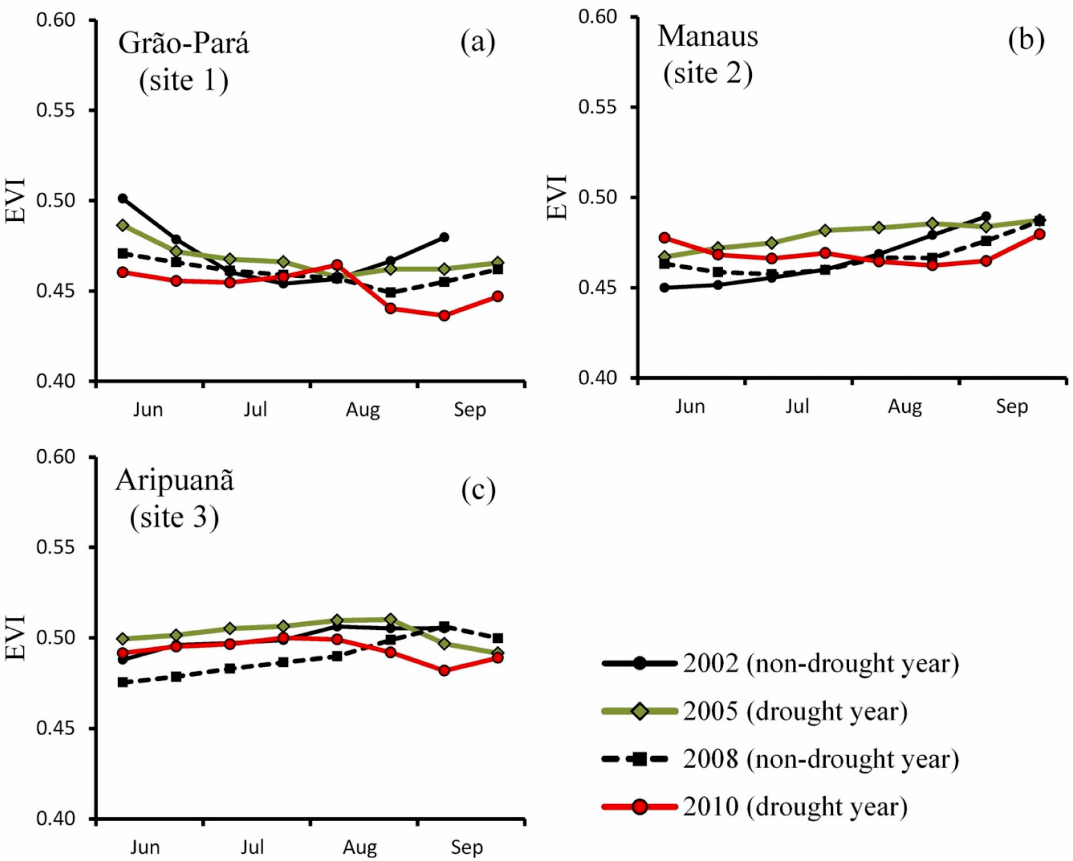
Figure 12. Variations in average BRDF–corrected enhanced vegetation index (EVI) ( n = 100 pixels per site), as a function of the drought (2005 and 2010) and non–drought (2002 and 2008) years, for the sites ( a ) Gr ã o–Par á , ( b ) Manaus, and ( c ) Aripuan ã